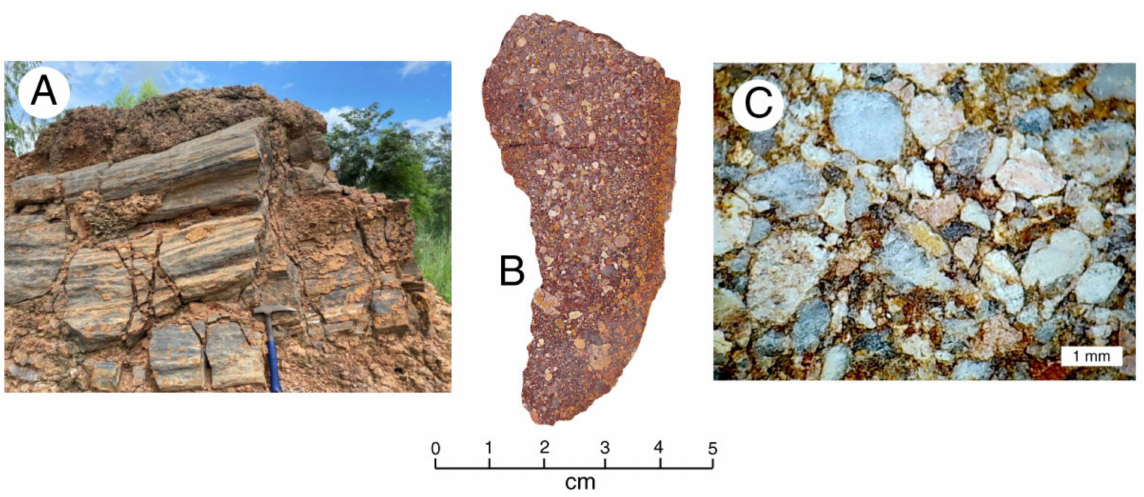
Figure 14. Mesozoic logs, Phichit Province, Thailand. ( A ) Logs are horizontal, enclosed by reddish alluvial sediment ( B ). Reddish color is caused by the lateritic matrix sediment. ( C ) Thin sections show angular, poorly sorted clasts set in an iron-stained matrix. Specimens provided by Yupa